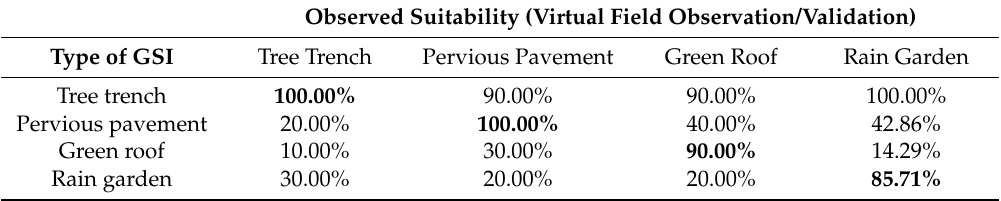
Table 3. Alignment of anticipated use with observed suitability from virtual field